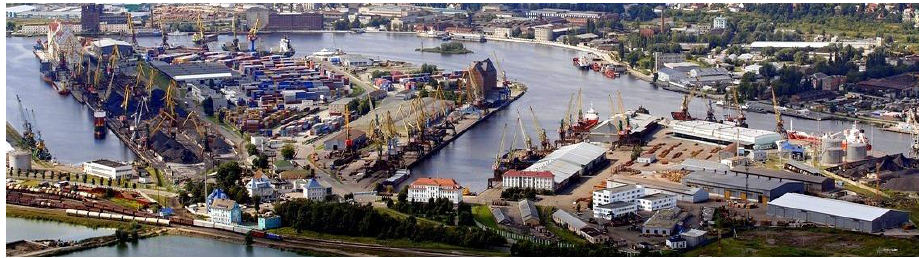
Figure 11. Port of Kaliningrad. Source: [82].